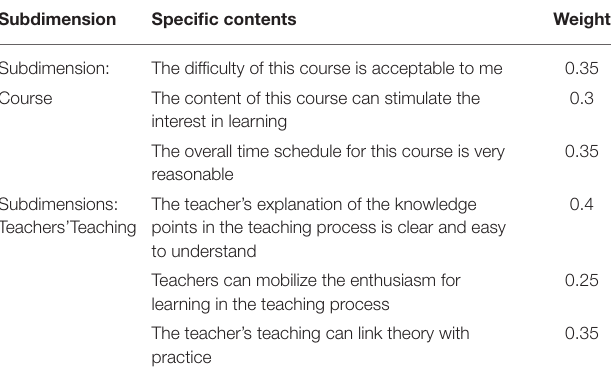
TABLE 4 | Survey content of teachers and students’ satisfaction with curriculum and